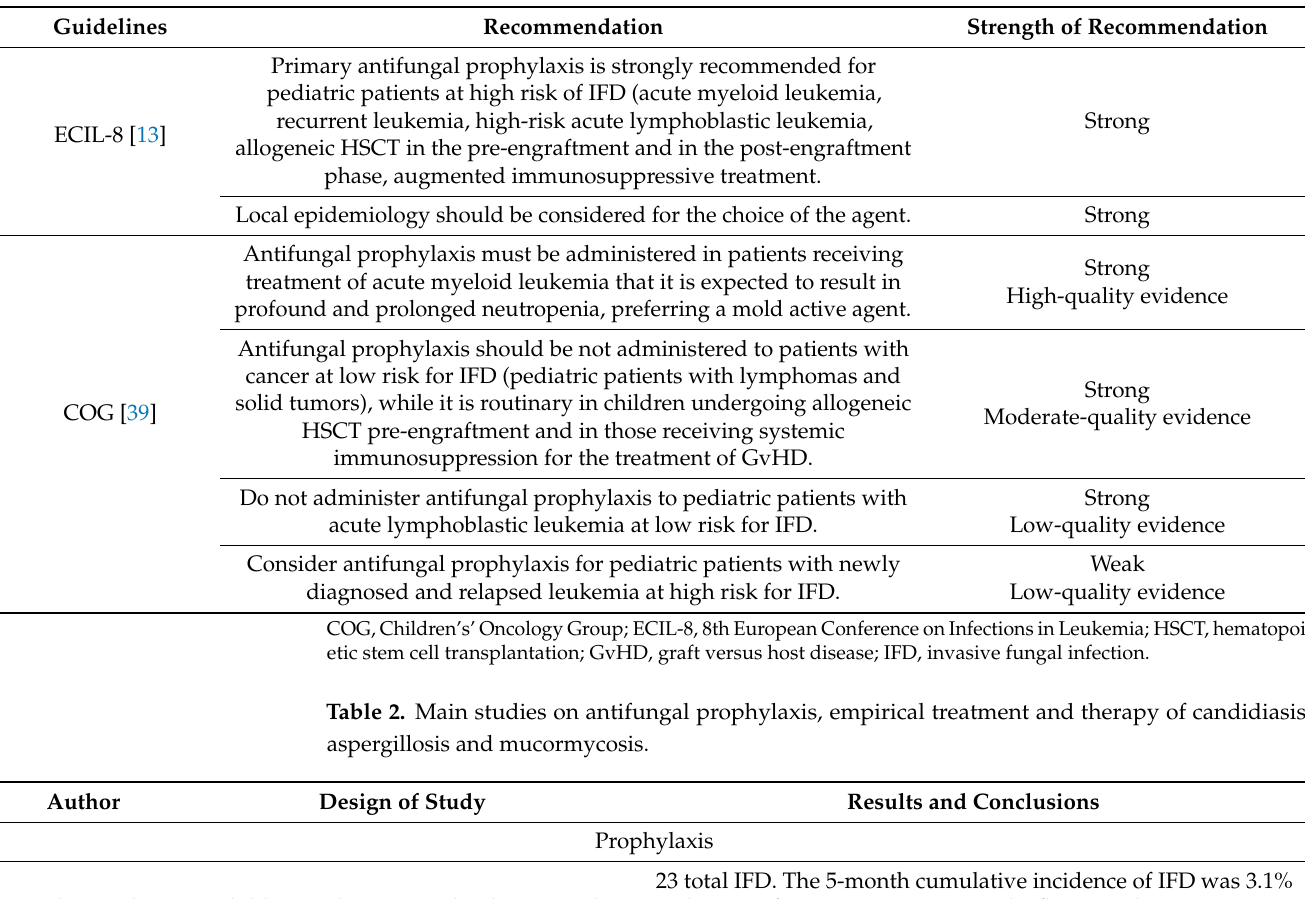
Table 1. Summary of main guidelines recommendations on antifungal prophylaxis in pediatric patients with cancer.